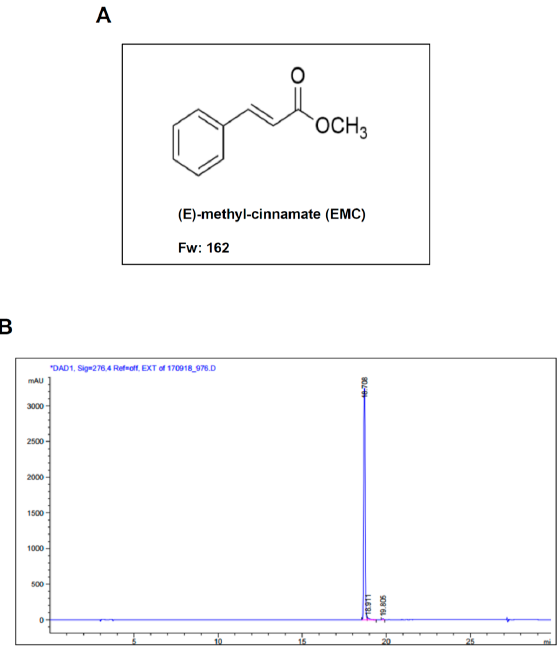
EMC. ( A ) Chemical structure of (E)-methyl-cinnamate (EMC) isolated from the seeds of Alpinia independent